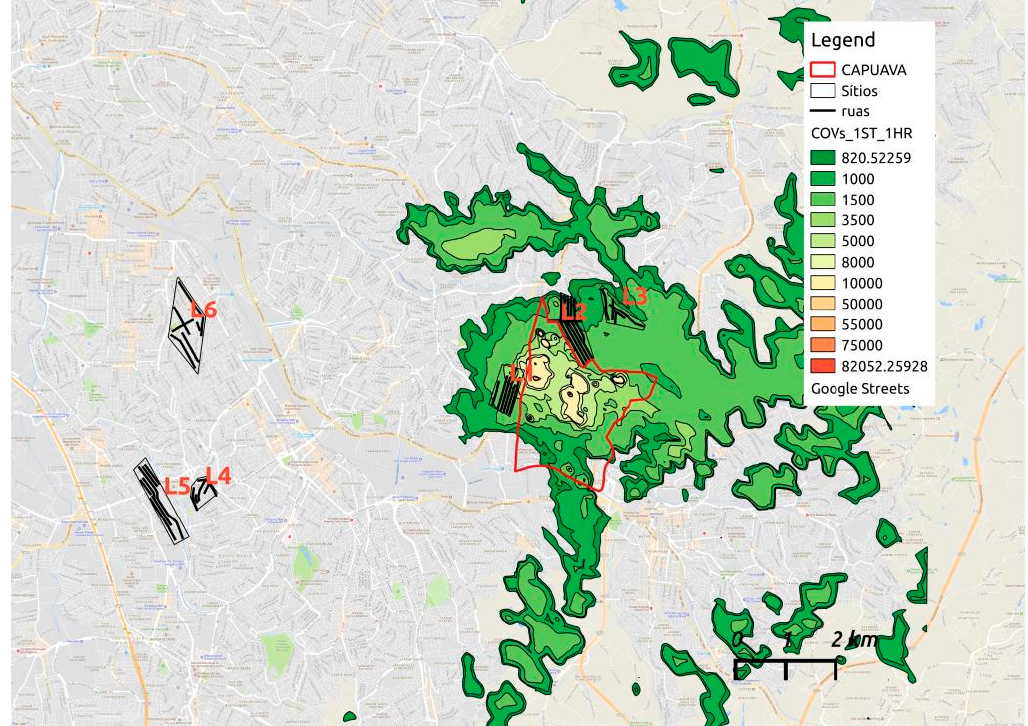
Figure 3. VOC maximum per hour average concentrations for the period between January of 2005 and December of 2009 using AERMOD simulation. Black lines are streets where epidemiologic